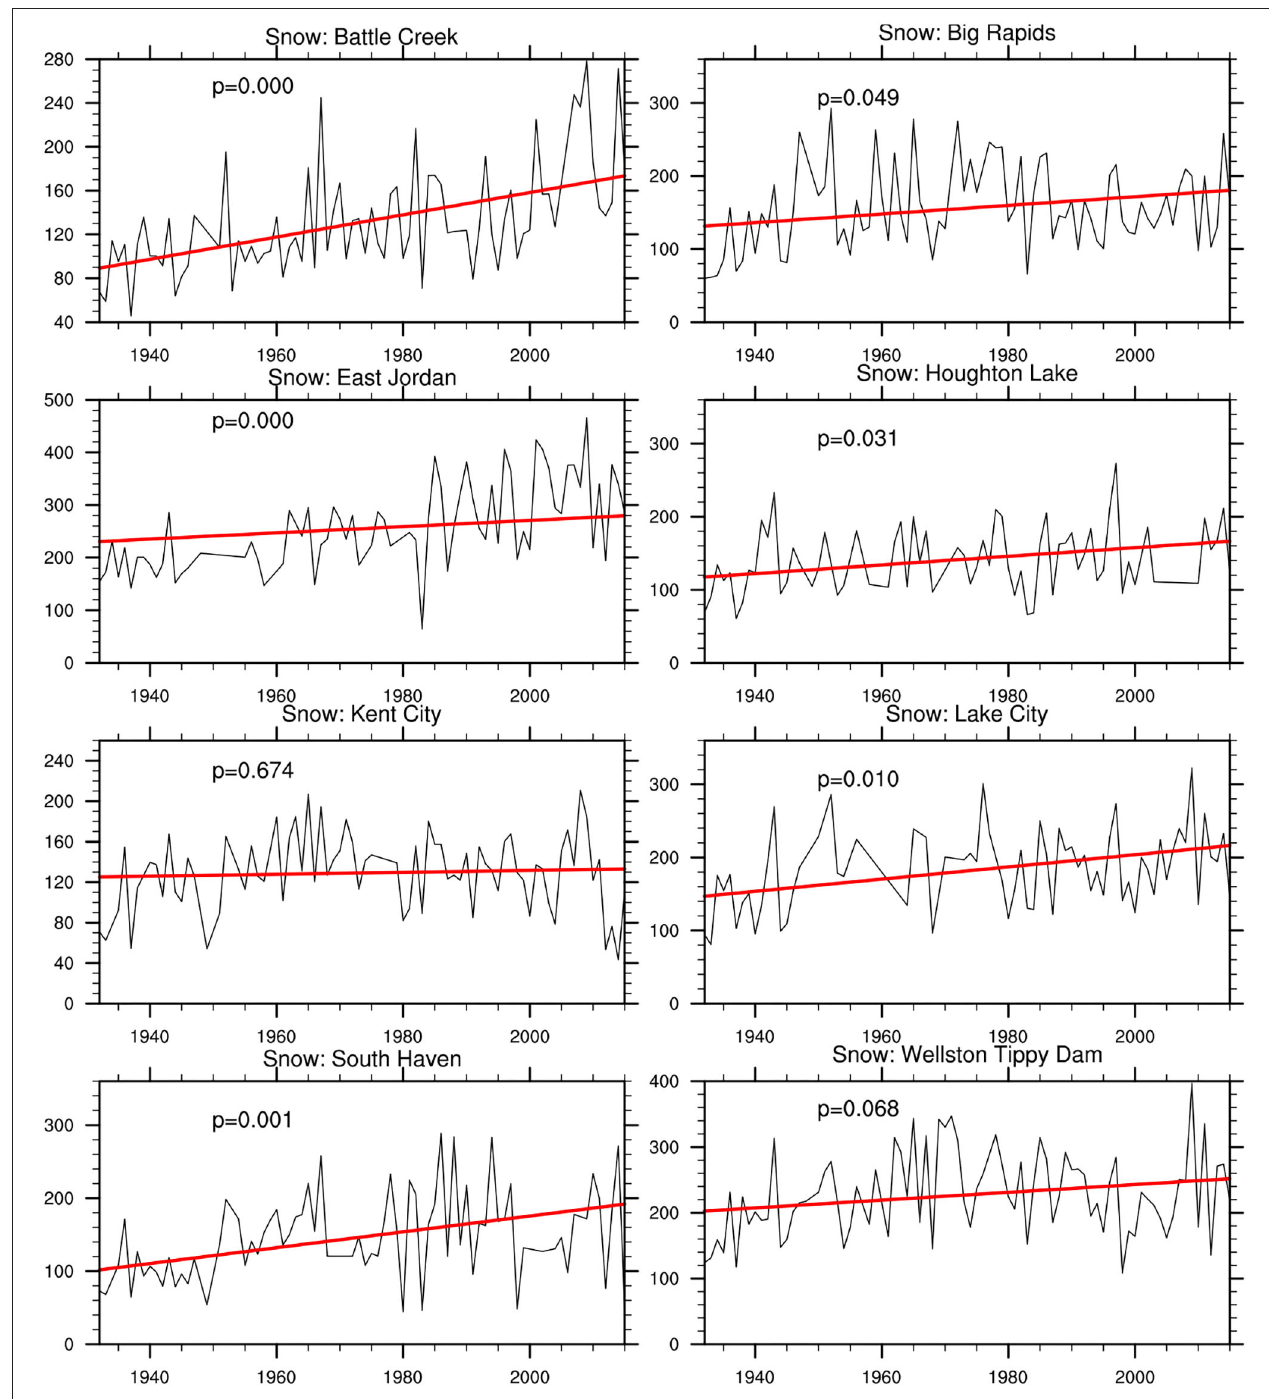
FIGURE 3 | Trends in annual total snowfall (cm) at the eight stations (refer to Figure 1 ) for the period of 1932–2015. The trend analysis was conducted using the Mann-Kendall test.